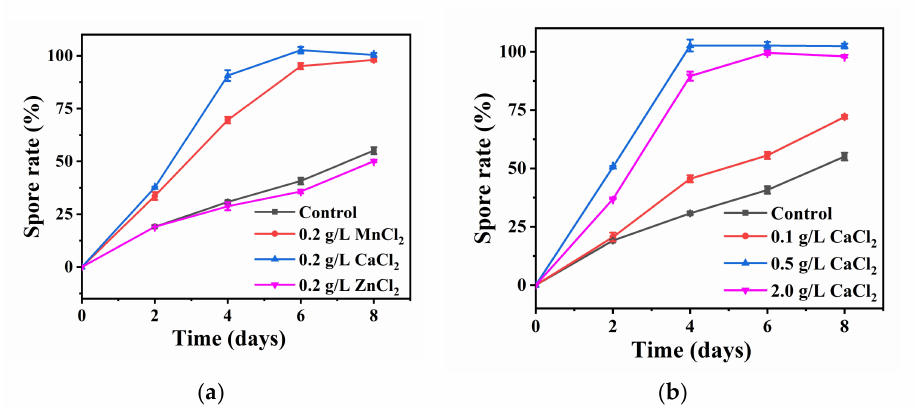
Figure 2. ( a ) Sporulation efficiency of B. subtilis with the same concentration of Mn 2+ , Ca 2+ and Zn 2+ ; ( b ) Sporulation efficiency of B. subtilis with different concentrations of Ca 2+